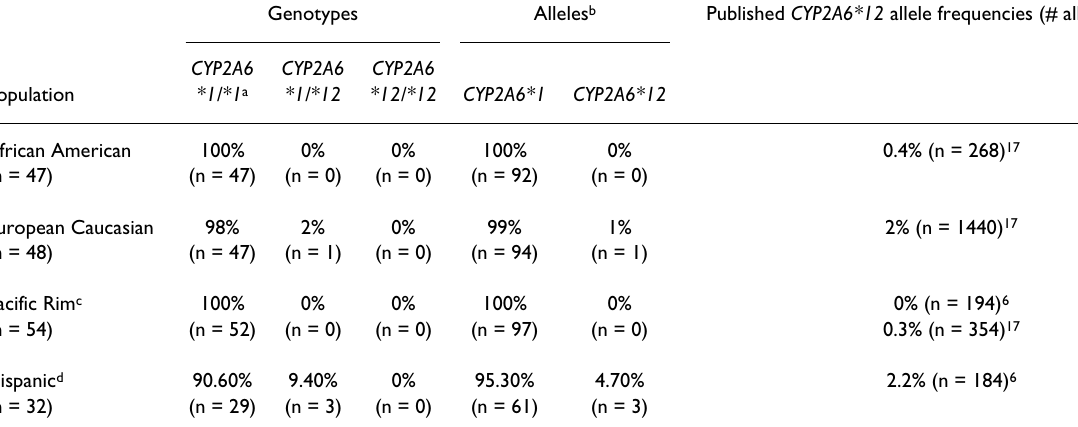
Table 1: CYP2A6*12 genotype and allele frequencies by ethnicity as determined by Pyrosequencing